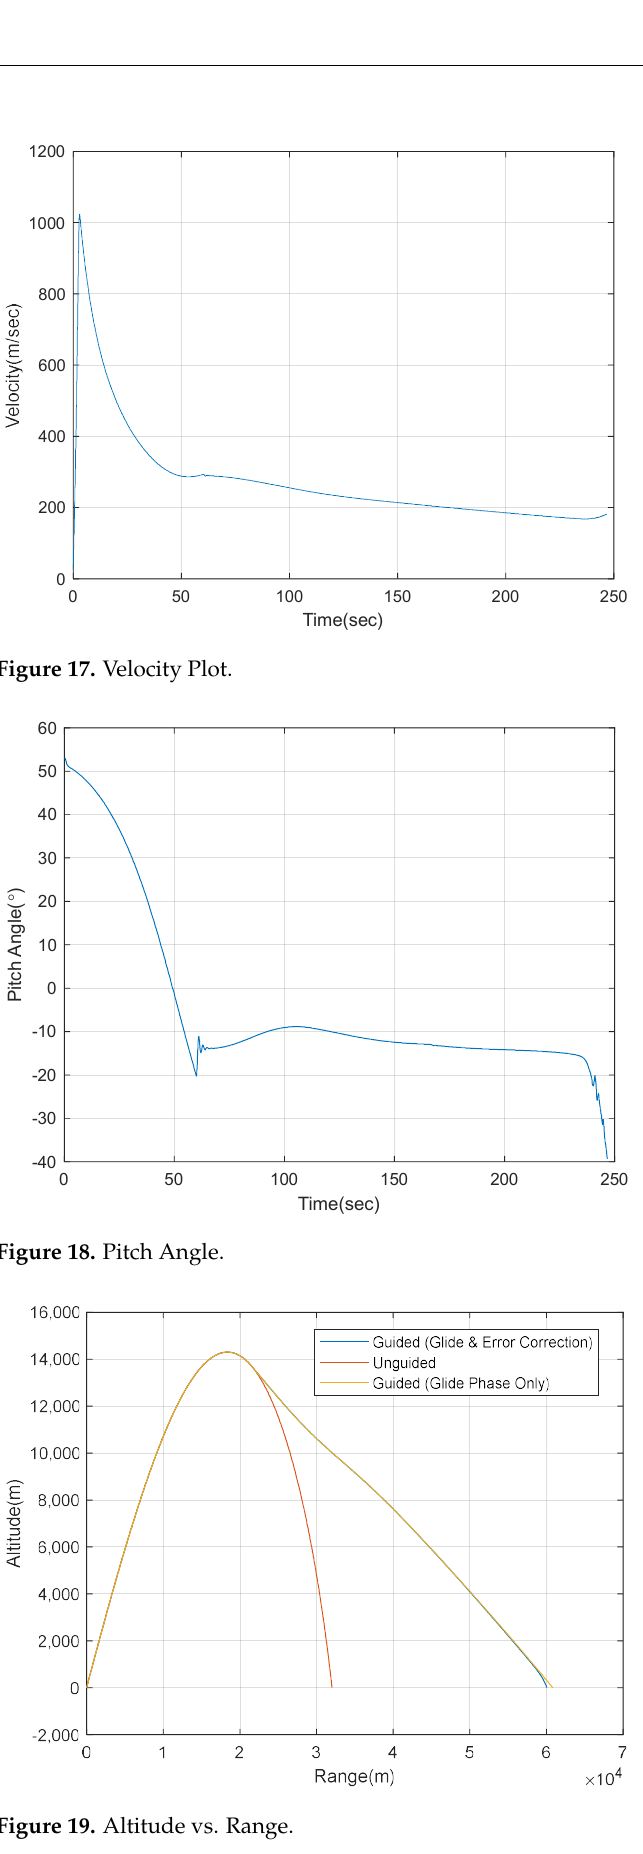
Figure 20. Altitude vs. Drift vs. Range. Figure 21. Angle of Attack. Figure 22. Angle of Side Slip. A l t i t ude ( m )